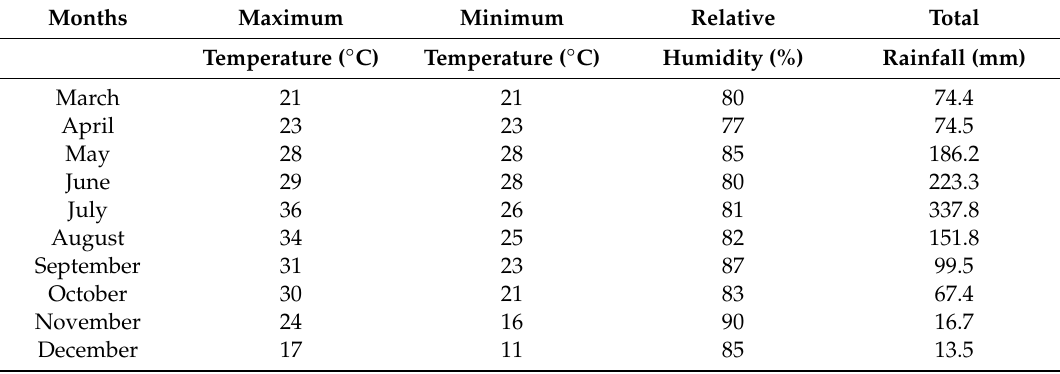
Table 1. Mean maximum and minimum temperature, relative humidity, and total rainfall during both growing seasons.